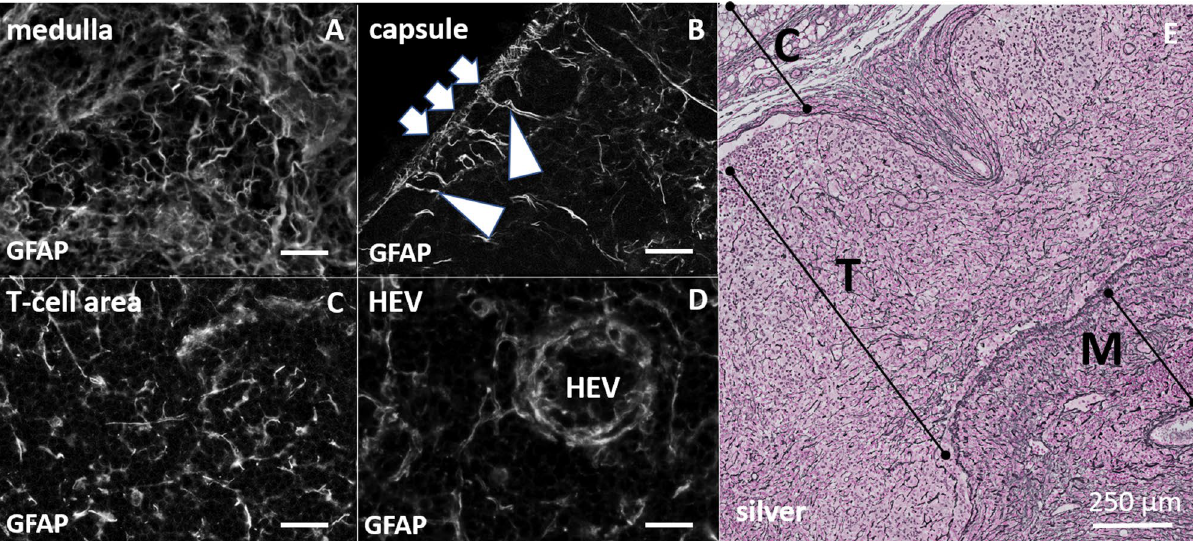
Figure 2. Left site ( A – D ), immunohistochemical staining with polyclonal anti-GFAP antibody (DAKO) in different areas of the lymph node, colorless display for impartial interpretation. ( A ) Undirected arrangement of branched structures in the medulla. ( B ) Clear signals in the capsule (arrow). Radially symmetric inward extending of longer directional signals (arrowheads). ( C ) Heterogeneous signal distribution with clearly reticular arrangement of signals in the T-cell area. ( D ) Concentric and dense packed signals around the high endothelial venules (HEV) (Scale bar for A – D 50 µm). Right site ( E ) silver staining of lymph node cross section. ( E ) Digital enlargement of a silver-stained cross-section through a lymph node. Magnification covers as much as possible areas from the capsule (C), T-cell region (T) and the medulla (M). The fibrous structures of this staining represent the reticular network in the lymph